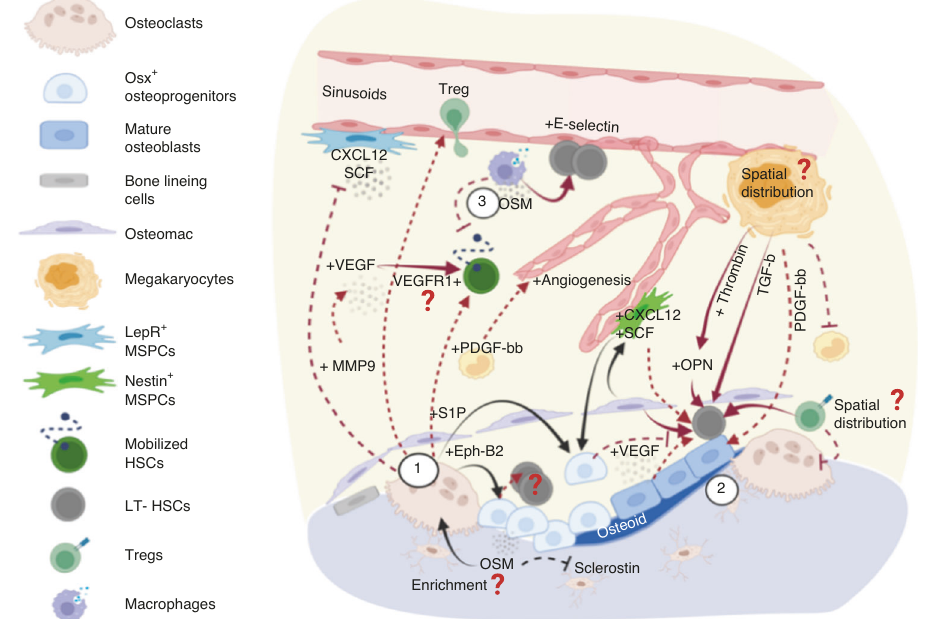
Fig. 2 Factors involved in the reversal stage of bone remodeling and their crosstalk with the hematopoietic compartment. (1) Osteoclasts secrete several coupling factors to promote osteodifferentiation during the reversal stage of bone remodeling and that also target hematopoietic cells. S1P acts through S1P 1 receptors that are highly expressed on hematopoietic cells to regulate cell traf fi cking, which is crucial for cell egress after treatment with mobilizing agents (e.g., G-CSF or GM-CSF). Osteoclast-derived Ephrin-B2 acts on EphB4-expressing osteolineage cells, leading to the subsequent expansion of long-term HSCs mediated via mechanisms that remain to be elucidated. Osteoclasts also recruit regulatory T cells, which may constitute immune-privileged sites that promote HSC survival. In addition, MMP9 secreted from osteoclasts modulates the bone marrow microenvironment in several ways, including the release of VEGF from extracellular matrix to promote angiogenesis and the degradation/shedding of CXCL12 and SCF to promote HSC mobilization. (2) In a bone remodeling unit, osteolineage cells, osteomacs, and megakaryocytes (MKs) work collaboratively to promote osteogenesis. Each unit produces abundant factors such as thrombin-cleaved, activated OPN, and MK-derived TGF- β , which regulate HSC dormancy. (3) Moreover, oncostatin M (OSM) secreted by osteolineage cells (e.g., MSPCs and osteoblasts) or immune cells (e.g., macrophages) plays pleiotropic roles to promote both remodeling (inducing RANKL expression) and osteodifferentiation (suppressing sclerostin expression). Importantly, OSM induces CXCL12 to inhibit cell mobilization and boost E-selectin-mediated HSC self-renewal/expansion. Overall, the reversal stage involves functionally diverse signaling pathways that promote dormancy, mobilization, and expansion. It will be insightful to understand whether HSC proliferation in such microenvironment is mediated by self-renewal-based expansion or loss of stemness, and whether active bone remodeling leads to enrichment in MK distribution, OPN/OSM concentration, and accumulation of regulatory T cells that are associated with the self-renewal potency and survival of Several studies have revealed the regulatory roles of osteo- (Fig. 3.3). This outcome is also consistent with the known role blasts in HSC function in the bone formation phase. For example, of osteoblast lineage cells in supporting B lymphopoiesis via the long-term HSCs (CD45 + /Lin − /BrdU + cells) appeared to be spatially associated with spindle-shaped N-cadherin + osteoblasts (Fig. 3.1). Inactivating the BMP receptor type 1a (BMPR1a) expanded the osteoblastic niche and the HSC number 57 Interestingly, HSCs (Lin − /CD48 − /CD41 − / CD150 + /CD49b − cells), likely a subset of long-term HSCs, have also been found to be closely associated with N-cadherin + bone and stromal cells. Conditional deletion of SCF in a N-cadherin + population signi fi cantly reduced the repopulating capacity of HSCs, especially under chemotherapy-induced stress condi- tions. 58 Moreover, Silberstein et al. showed that long-term HSCs were maintained by osteolineage cells that expressed high levels of IL-18 , angiogenin , and Embigin (Fig. 3.2). Deletion of angiogenin in Nestin + MSPCs, Osterix + osteoprogenitors, and NG2 + periarter- iolar cells resulted in an increased number of cycling HSC long- term HSCs and compromised multilineage reconstitution. In contrast, Angiogenin deletion from Col1a1 + osteoblasts increased the cycling activity of common lymphoid progenitors and lymphoid reconstitution defects after competitive transplanta- tion, suggesting a regulatory role for mature osteoblasts in lymphopoiesis. 59 This hypothesis is supported by the recent fi nding indicating that mechanically induced bone formation maintains the population of lymphoid-primed progenitors 60